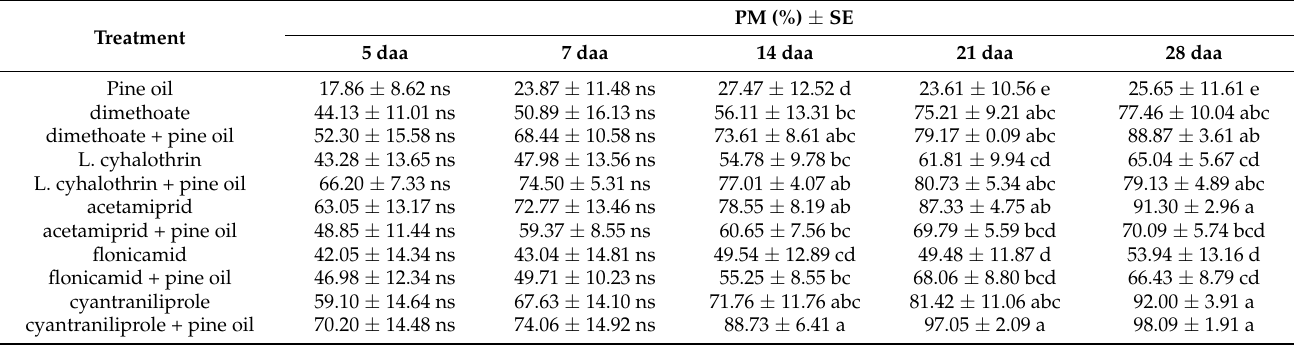
Values with different letters are significantly different among the treatments tested for each assessment period (Fisher’s LSD test, p < 0.05). PM: percentage of corrected mortality; SE: standard error; ns: not significant; daa: days after application; L. cyhalothrin: lambda-cyhalothrin. Individuals expressed as the mean of PM (%) ± standard error (SE) in different assessment timings (5; 7; 14; 21 and 28